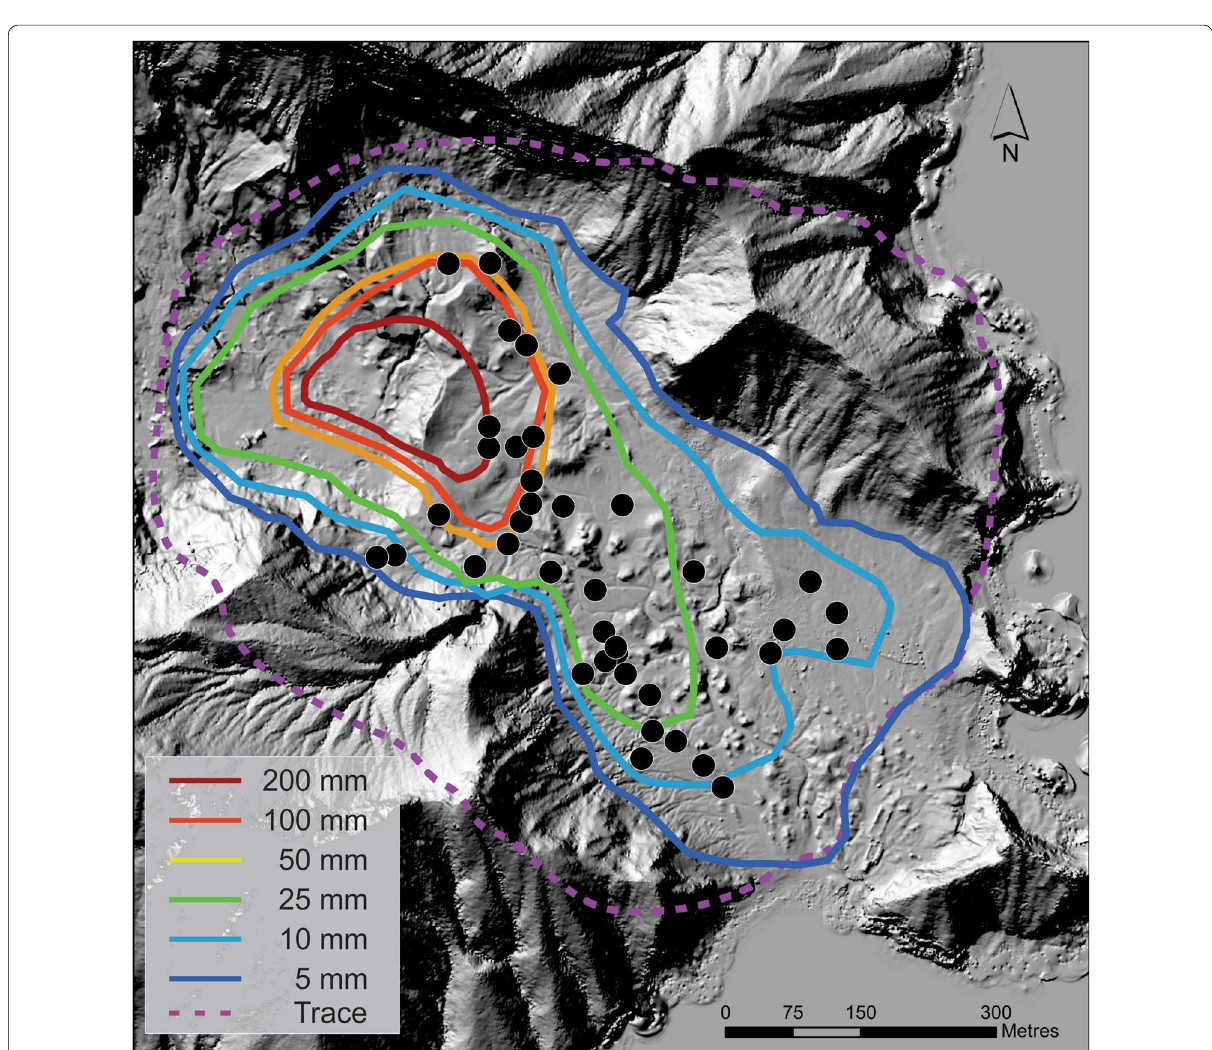
Fig. 10 Isopach map of the pyroclastic surge component of the eruption. This was created using thickness data from two separate field visits and aerial images of the deposit distribution. Note the thickest part of the deposit coincides with the high topographic feature—Donald Mound. We have also traced the inflated co-surge plume using aerial images up on the crater